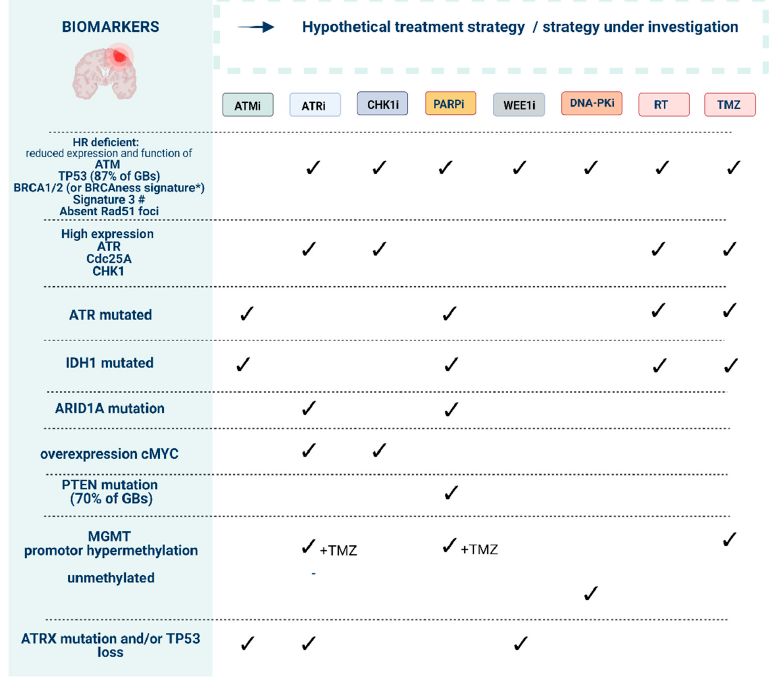
Figure 4. Preliminary biomarkers to guide the use of DNA damage response (DDR) inhibitors in order to reach synthetic lethality. Ataxia-telangiectasia mutated (ATM), ATM-RAD3-related protein (ATR), checkpoint kinase-1 and -2 (CHK1/2), DDR kinase inhibitor (DDRi), DNA-dependent protein kinase (DNA-PK), poly (ADP-ribose) polymerase-1 and -2 (PARP). * “BRCAness” signature can in- clude mutations in ATM, ATR, BAP1, BRCA1, BRCA2, CDK12, CHK1, CHK2, FANCA, FANCC, FANCD2, FANCE, FANCF, PALB2, NGS1, WRN, RAD50, RAD51B, RAD51C, RAD51D,